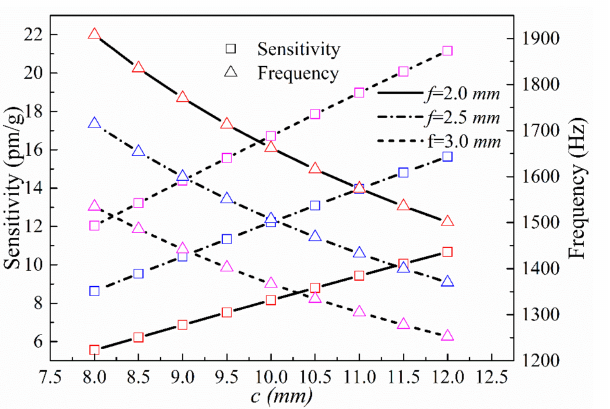
Figure 7. Sensitivities and natural frequencies in the z-direction as a function of c at different values of f.